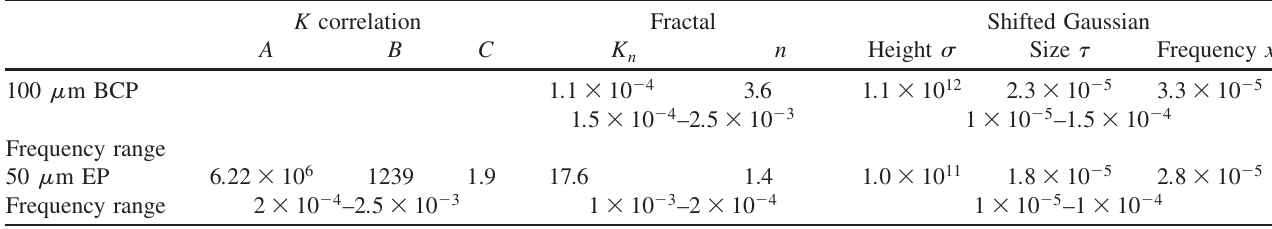
TABLE V. Fitting parameters (unit: nm) for Fig.